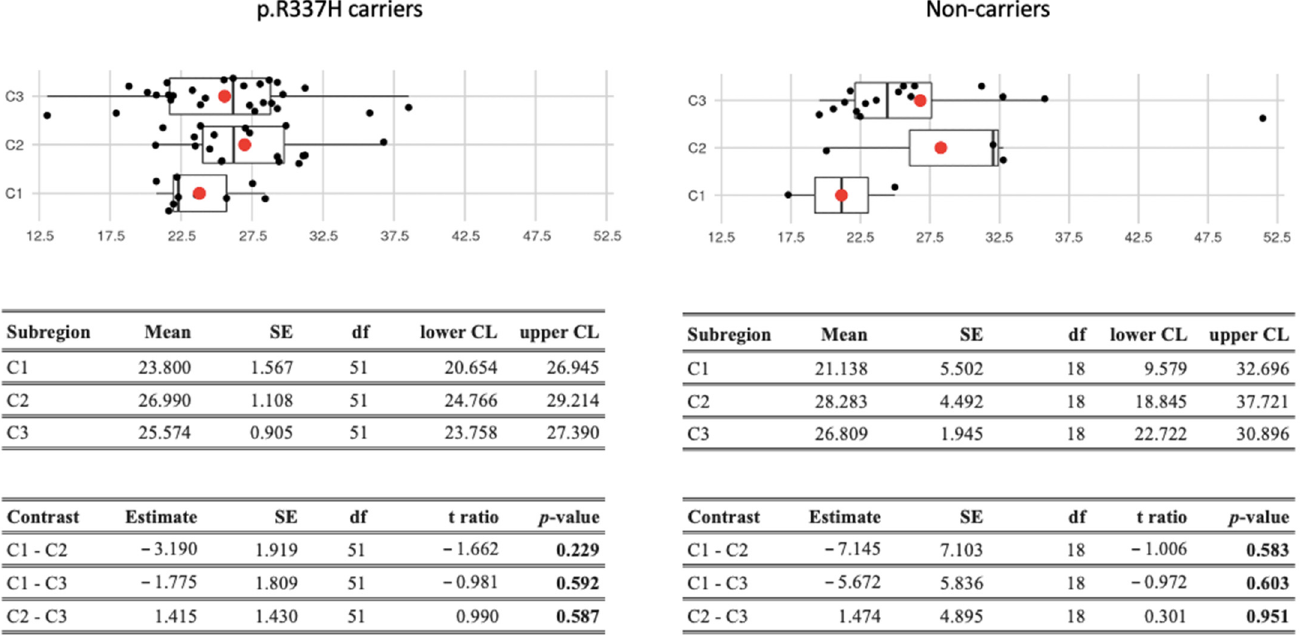
Figure 3. Mean (red dots) and median (vertical lines) BMIs are shown in boxplots. Estimated marginal means from a linear model (analysis of variance) detected lower and upper confidence limits (CL), and the p values between two subregions (contrast). SE, standard error; df, degree of freedom.